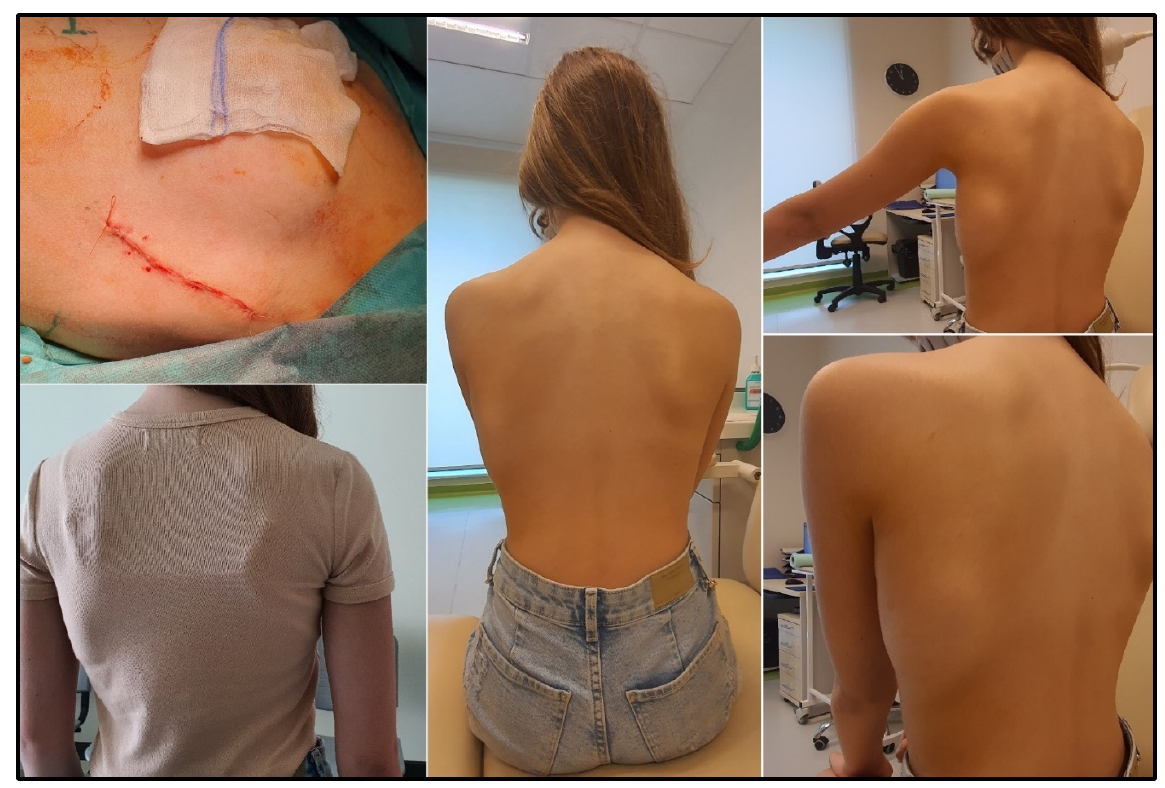
Figure 5. Patient 9. Cosmetic effect after S-ICD implantation in a 12-year-old female patient after cardiac arrest in the course of ventricular fibrillation.